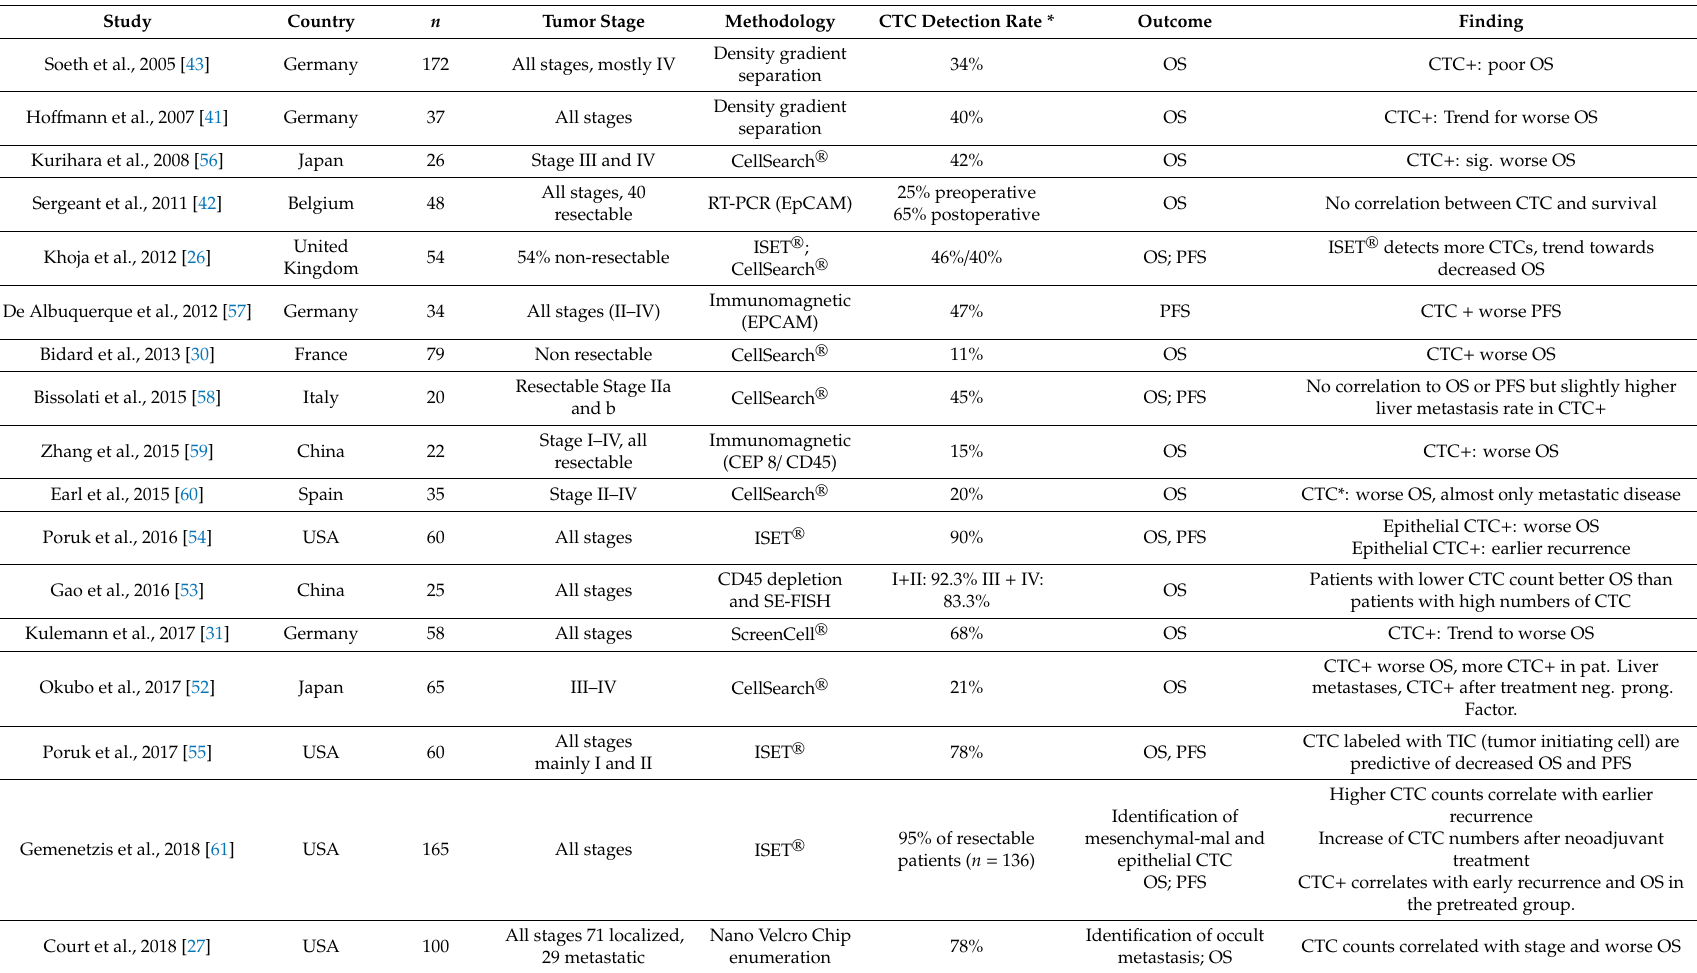
Table 1. Studies evaluating CTCs in pancreatic ductal adenocarcinoma (PDAC) including survival